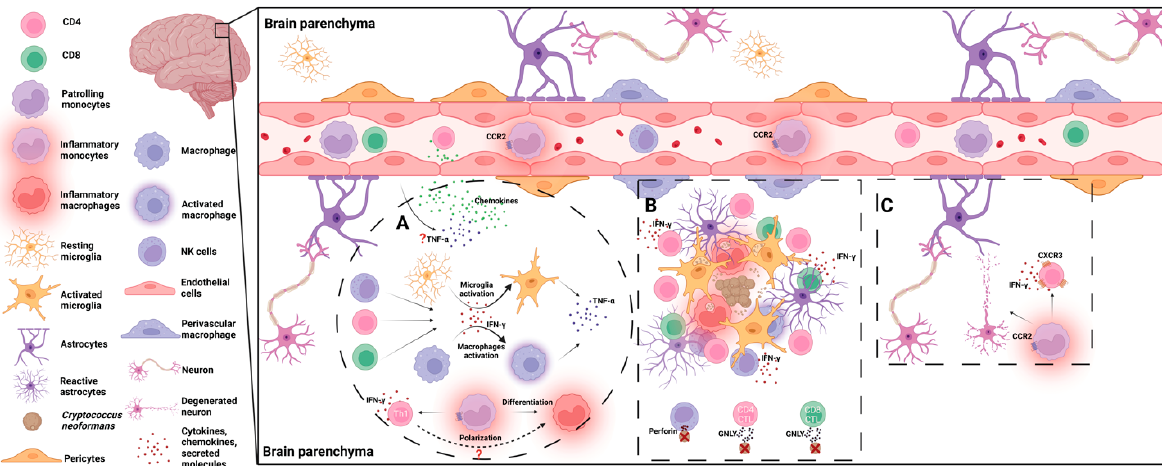
Figure 2. Host immune responses to C. neoformans in the brain. ( A ) Following brain infection of C. neoformans , TNF- α and chemokines are produced, facilitating leukocytes’ migration to the brain parenchyma. IFN- γ produced by CD4 + /CD8 + T cells and NK/NKT cells promotes the activation of microglia and macrophages. Activated microglia and macrophages secrete TNF- α , further driving brain inflammation. Recruited inflammatory monocytes differentiate into inflammatory macrophages and help shape Th1 immune responses, which are required for fungal clearance. ( B ) As the resident glial cells, microglia and astrocytes are the first cells to respond to invading yeast cells. Later, recruited leukocytes including CD4 + /CD8 + T cells, NK/NKT cells, and inflammatory monocyte/macrophages accumulate in and around the fungal clusters. As effector cells, microglia and macrophages internalize the fungal cells. T cells and NK cells secrete IFN- γ to promote fungicidal activity of these phagocytes. NK cells and T cells are also involved in direct killing of the fungal cells through release of perforin or granulysin (GNLY). ( C ) Inflammatory responses are required for fungal clearance in the brain but must be tightly controlled. Inflammatory monocytes and IFN- γ -secreting CXCR3 + CD4 + T cells facilitate neuronal damage and cause immunopathology during cryptococcal meningoencephalitis.